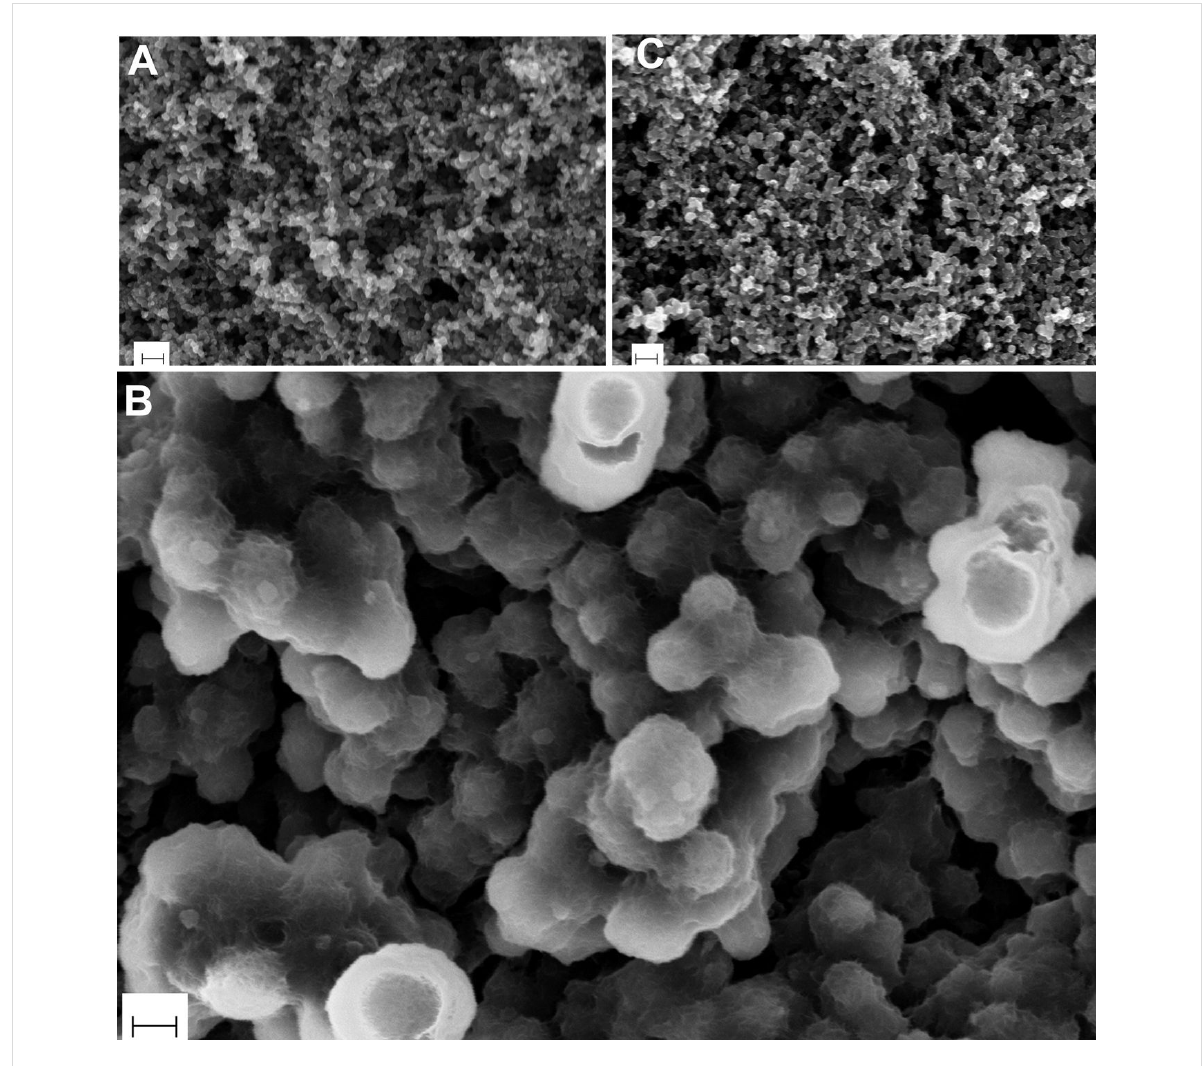
Figure 4: SEM micrographs of (A) pristine electrode, (B) discharged electrode for which the capacity was limited at 500 mAh·(g carbon) − 1 and (C) recharged electrode of Li–O 2 batteries. Note that the large Li 2 O 2 particles in (B) appear to have a hollow structure with a smooth surface and nodular morphology. The scale bars correspond to 200